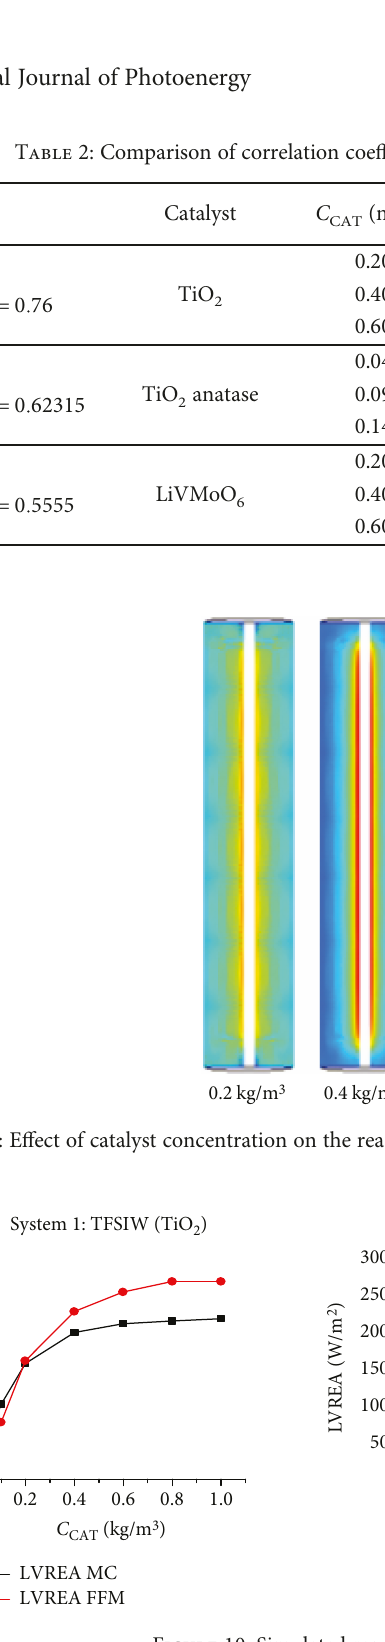
Figure 10: Simulated results of incident radiation as function catalyst